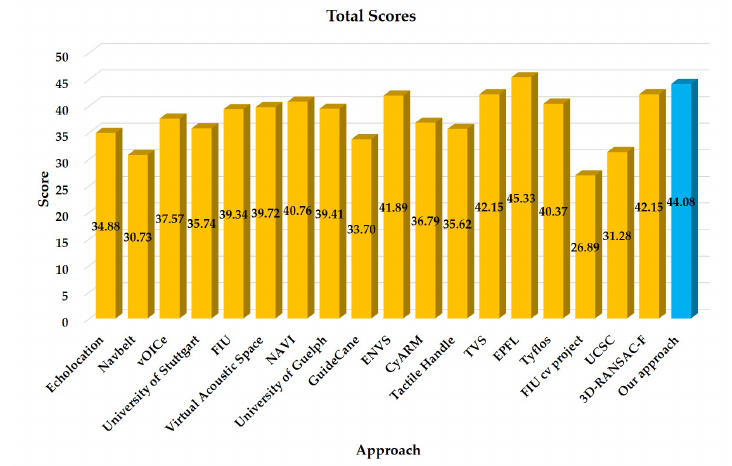
Figure 16. Maturity ranking, which shows the total score for each approach. From left to right: Echolocation, Navbelt, vOICe, University of Stuttgart, FIU, Virtual Acoustic Space, NAVI, University of Guelph, GuideCane, ENVS, CyARM, Tactile Handle, TVS, EPFL, Tyflos, FIU cv project, UCSC, 3D-RANSAC-F [9] and our approach.